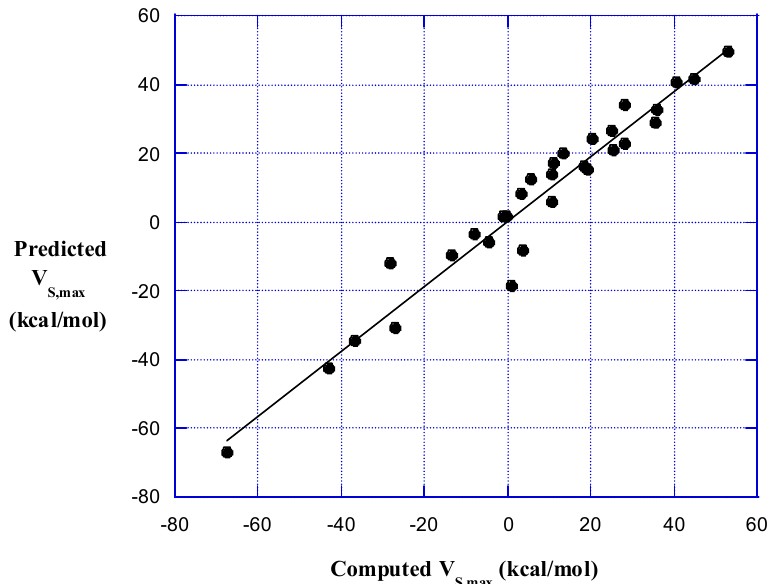
Figure 2. Relationship between predicted and computed V S,max and V S,min of halogen atoms X in AX diatomic molecules. The R 2 is 0.943.